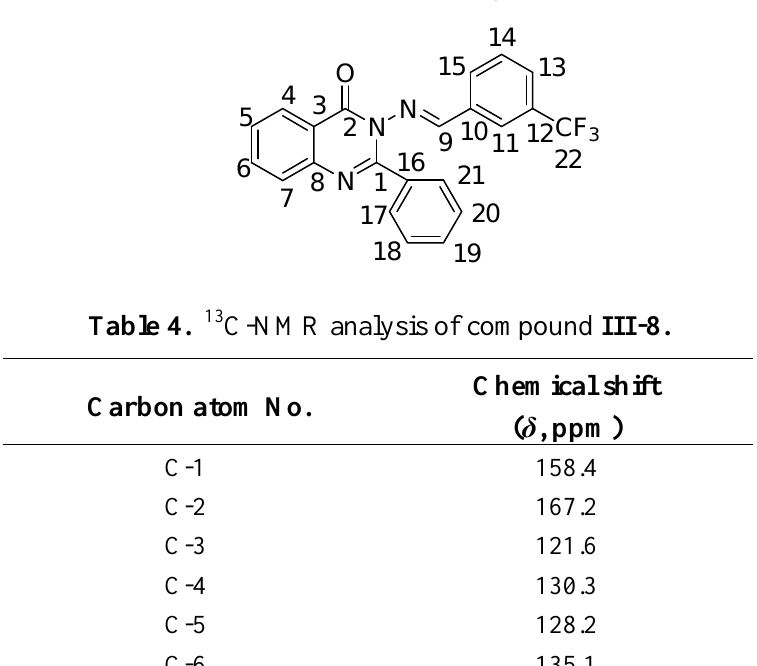
Figure 2. The structure and carbon atoms assignment of compound III-8 .